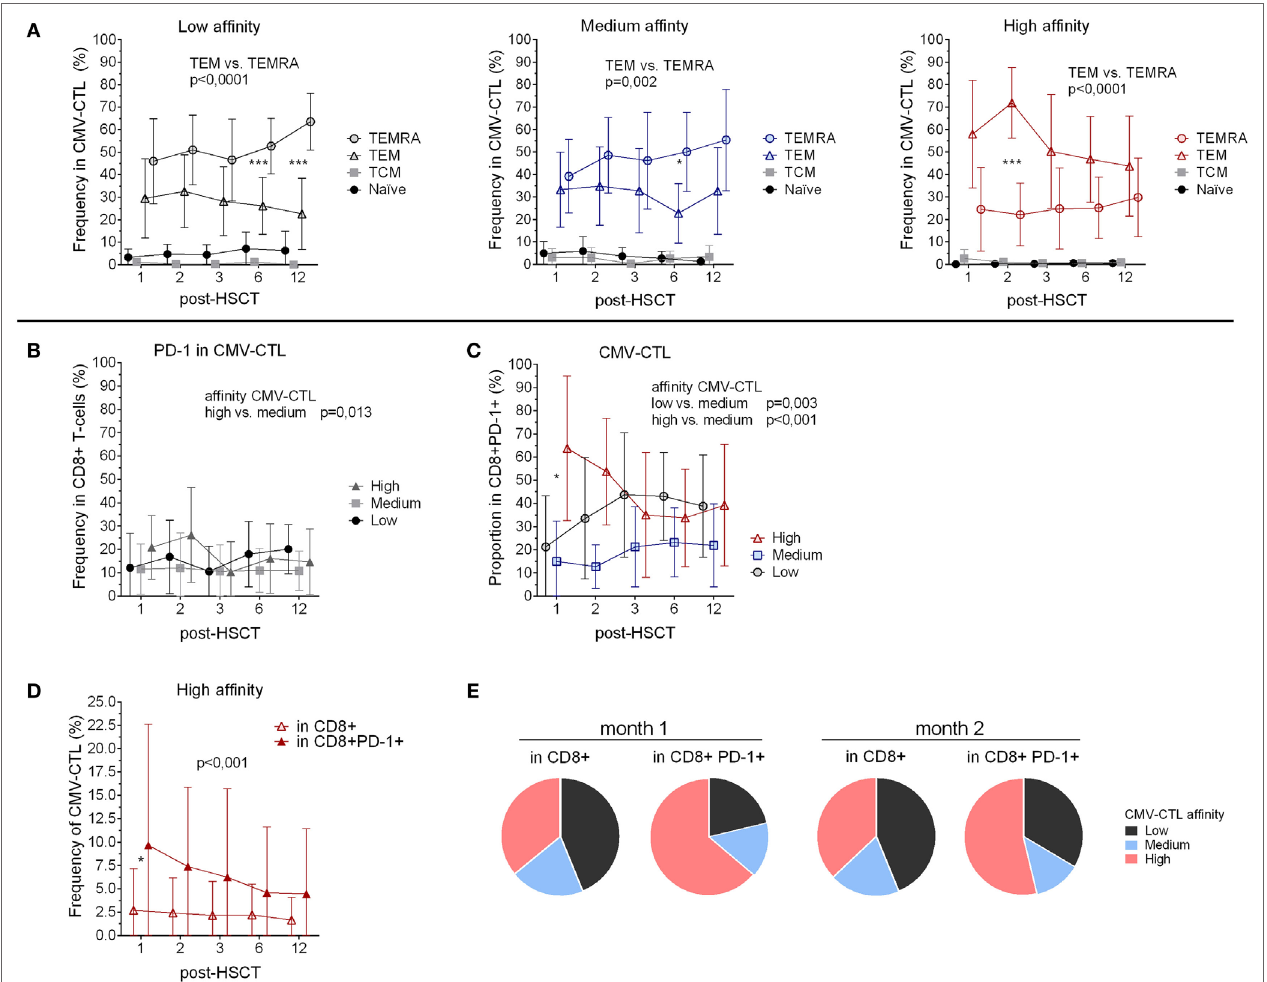
FigUre 2 | Memory phenotype and PD-1 expression of the cytomegalovirus(CMV)-specific CD8 + cytotoxic T-lymphocytes (CMV-CTL) with different T-cell receptor affinities over time post-hematopoietic stem cell transplantation (HSCT). (a) Memory phenotype of the different CMV-CTL subpopulations. (b) PD-1 expression in the different CMV-CTL subpopulations (c) Proportion of the high/medium/low-affinity CMV-CTL in the CD8 + PD-1 + T-cell population. (D) Comparison of the high-affinity CMV-CTL frequency between the total CD8 + T-cell population and the CD8 + PD-1 + T-cell population. Mean and SD are represented. Two-way ANOVA was used to detect differences between two groups over time. * p < 0.05, ** p < 0.01, *** p < 0.001. (e) Pie charts with the proportion of high/medium/low-affinity CMV-CTL the total CD8 + T-cell population and the CD8 + PD-1 + T-cell population at month 1 and 2